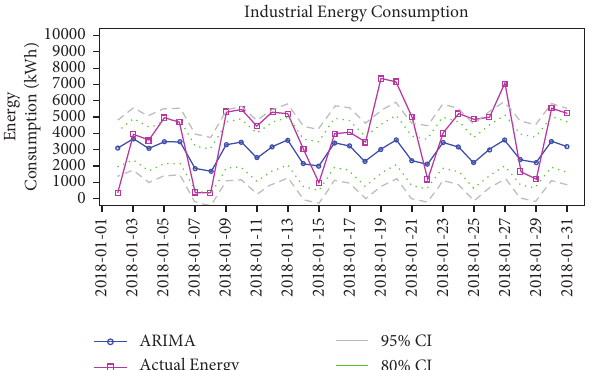
Figure 18: Diagram showing the comparison between actual energy data and ARIMA forecasted energy data of Jan